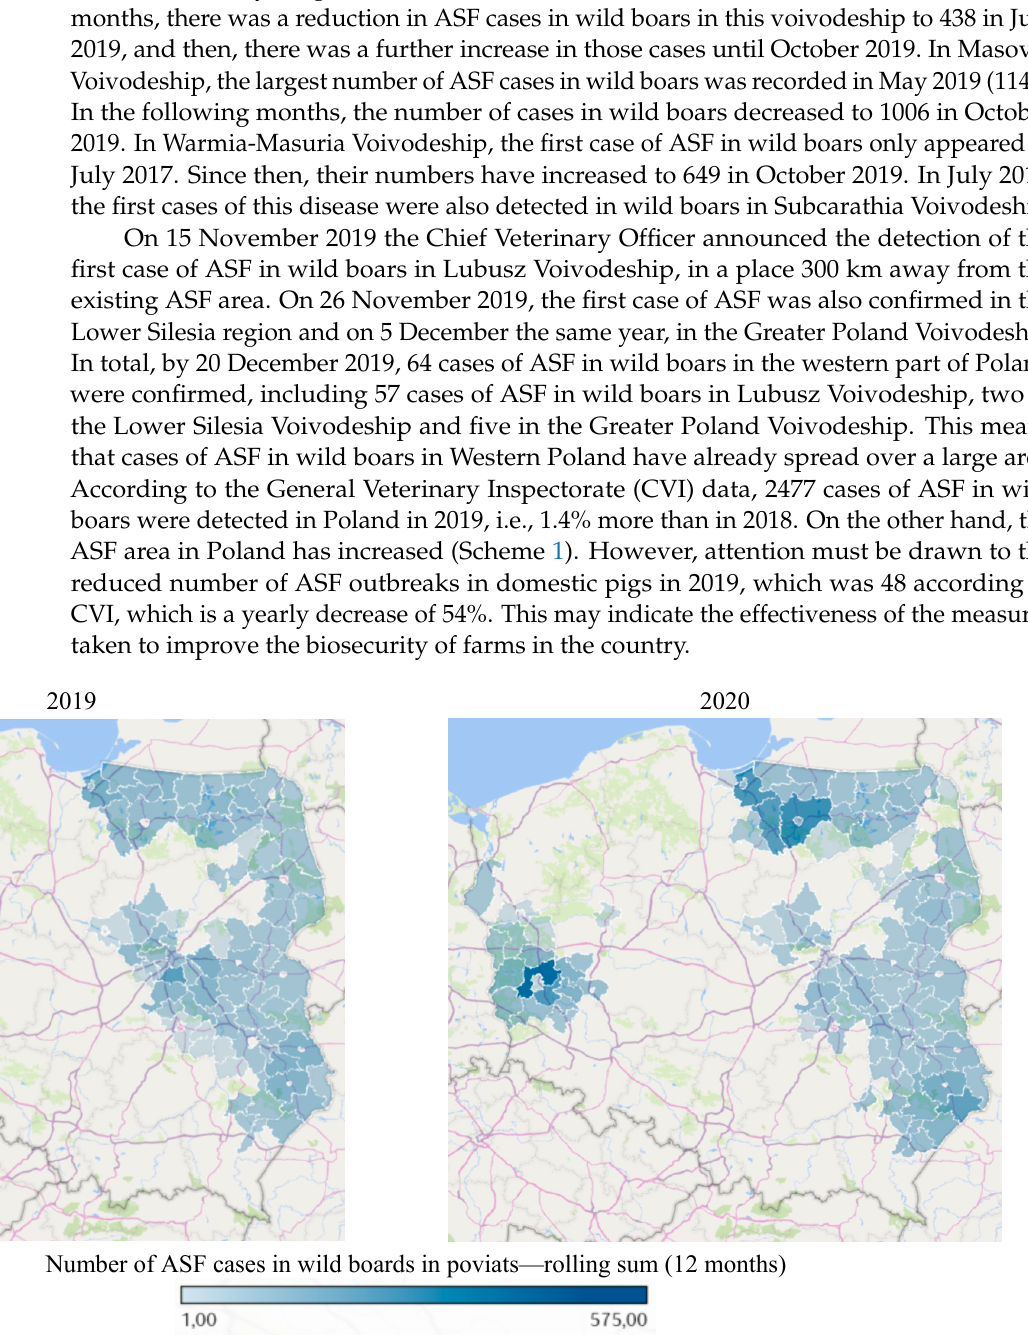
0.00.51.01.52.02.53.0 0123456789